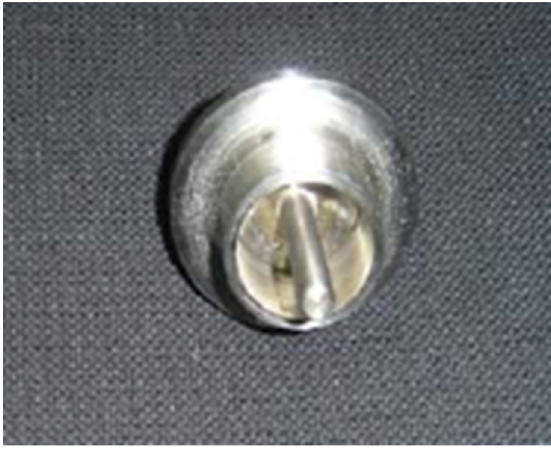
Figure 9. Distal securing element.